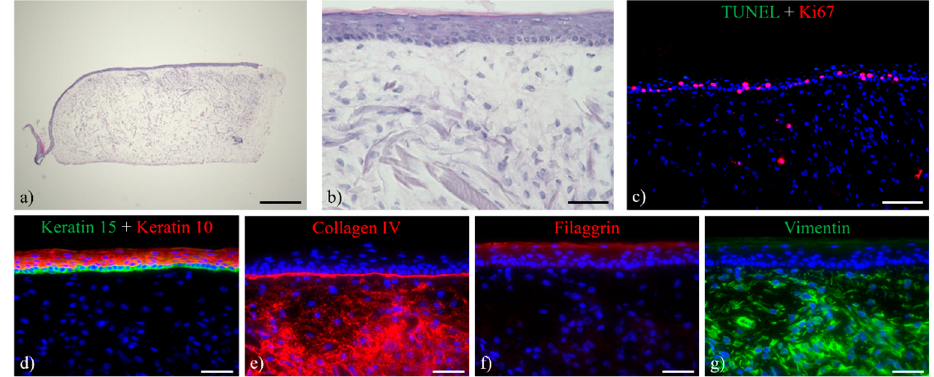
Figure 10. HE staining and immuno-labeling of ftSE cultured for seven days in the 2OC. ( a , b ) HE stain of the ftSE showed preserved morphology comprising a multilayered epidermis. ( c ) TUNEL-Ki67 (green and red) staining of the ftSE revealed a considerable number of proliferating cells within the basal layer of the epidermis, while only a few apoptotic cells could be detected. ( d ) Keratin 10 (red)/15 double stain, ( e ) collagen IV (red), ( f ) filaggrin (red), and ( g ) vimentin (green) staining indicate advanced levels of differentiation within the ftSE cultured in the 2OC. Counterstaining of cell nuclei with DAPI (blue). ( a ) Scale bar: 500 μ m. ( b , d – g ) Scale bar: 50 μ m. ( c ) Scale bar: 100 μ m.